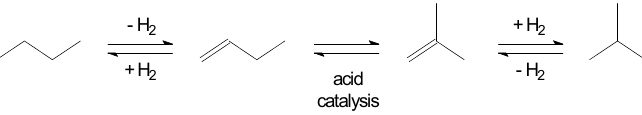
Figure 3. Hydroisomerisation of n -butane to isobutane.